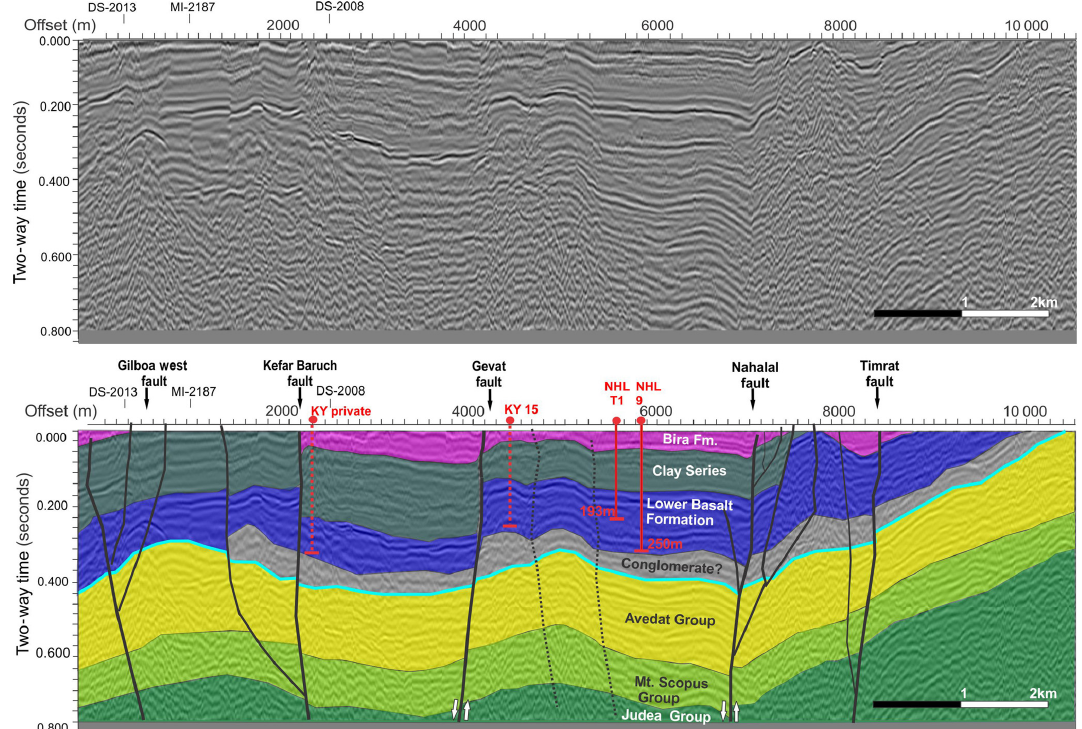
Figure 11. Multichannel seismic reflection profile line MI-2178. Strike-slip faults with a normal component in the frame of Plio-Pleistocene lateral shear adjacent to Mt. Carmel and Tiv’on blocks. Normal faulting vertically offsets basin fill units. Post-Bira Formation folding (postdating uppermost Miocene–Pliocene) is assigned to the strike-slip shear on the originally normal faults. A paleo alluvial fan, predating the vertical offset, is depicted by the Clay Series. Celeste horizon – RTS; dashed lines – projected wells. NHL – Nahalal; KY – Kefar Yehoshua. Location: Fig. 3; unit color code – Fig. 2. Vertical exaggeration: ×